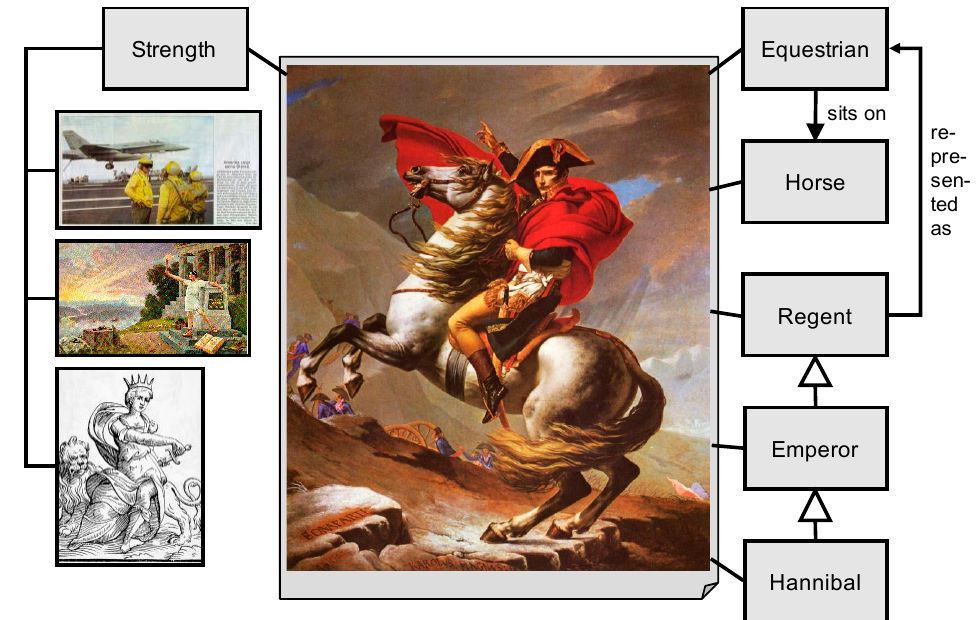
Figure 6. Intentional and extensional concept semantics in concept-oriented content management (CCM). Associations between images (Napoleon Crossing the Alps) and related concepts can be read in two ways. Sets of images define a concept, and concepts give meaning to an image.